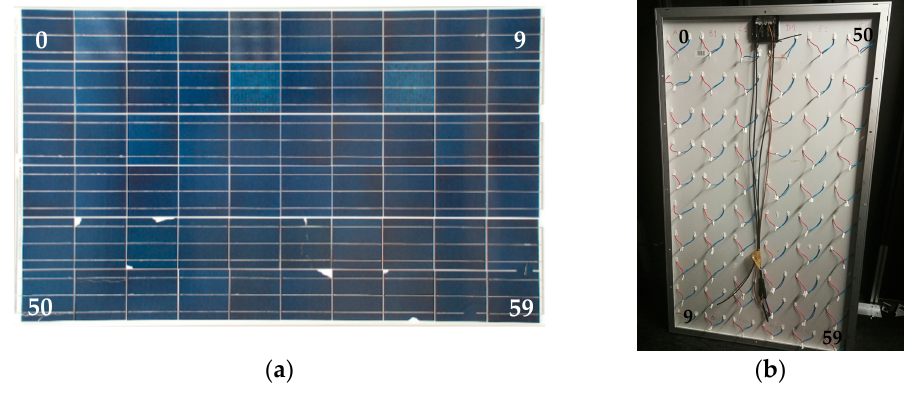
Figure 1. ( a ) Front view of the module. ( b ) Back view of the